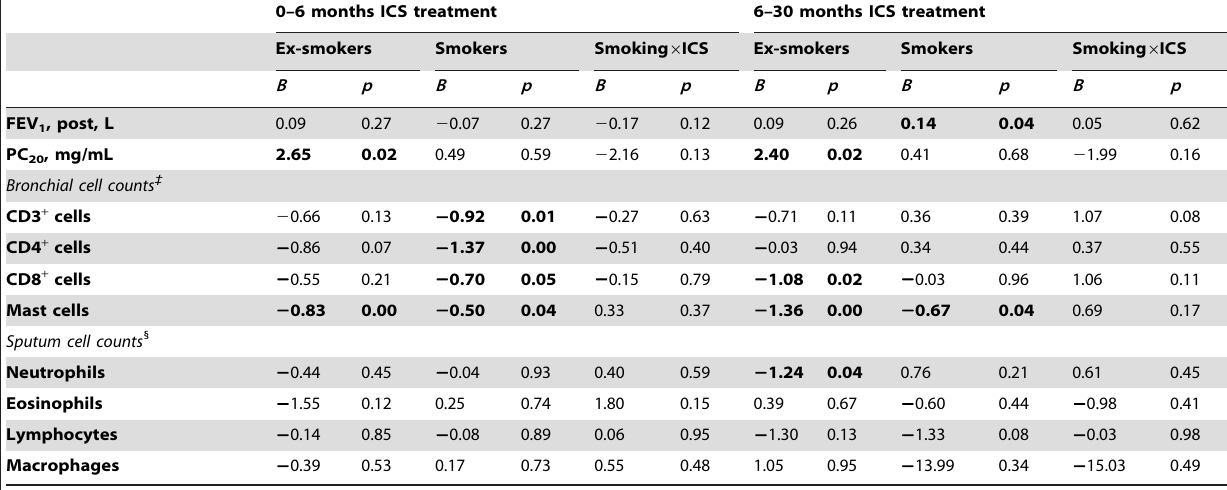
Table 2. Multiple regression analyses: effects of ICS treatment in smokers and ex-smokers, and the interaction between ICS treatment and smoking (smoking 6 ICS) on changes in lung function, hyperresponsiveness and inflammatory cells in biopsies and